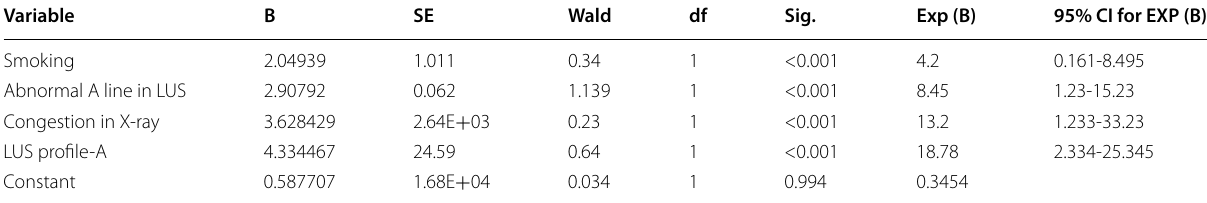
Table 3 Variables in the regression model